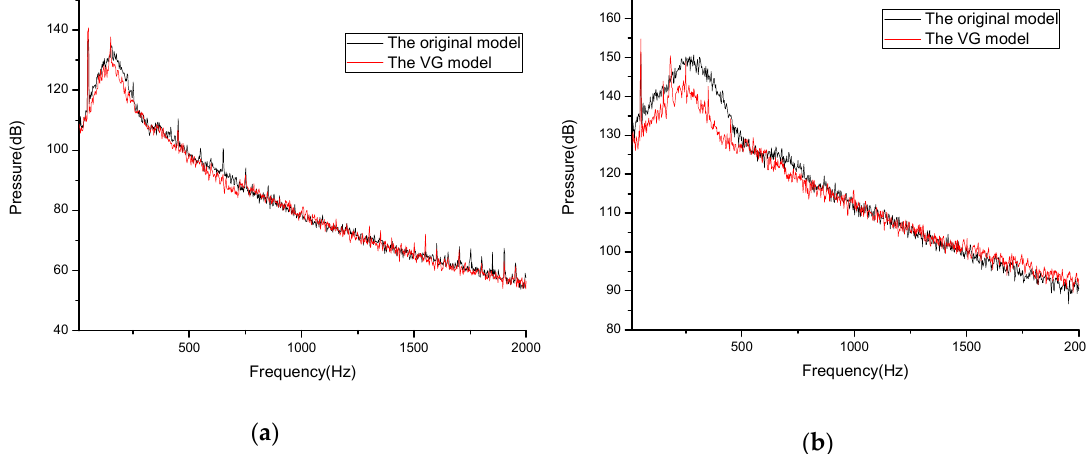
Figure 27. The turbulent fluctuation pressure measured by the fluctuation pressure sensor at different flow velocities: ( a ) 4.62 m/s; ( b ) 8.68 m/s.